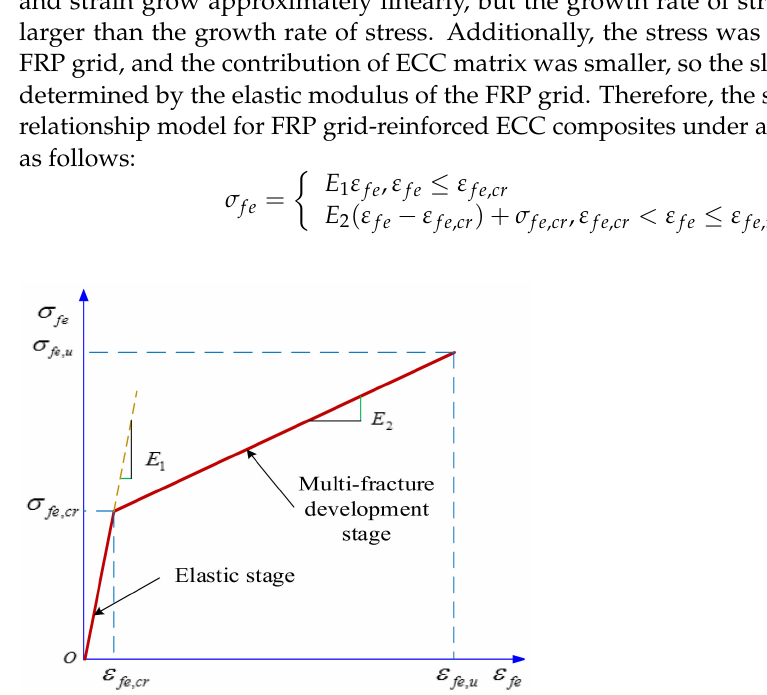
Figure 9. Uniaxial tensile stress–strain model for FRP grid-reinforced ECC